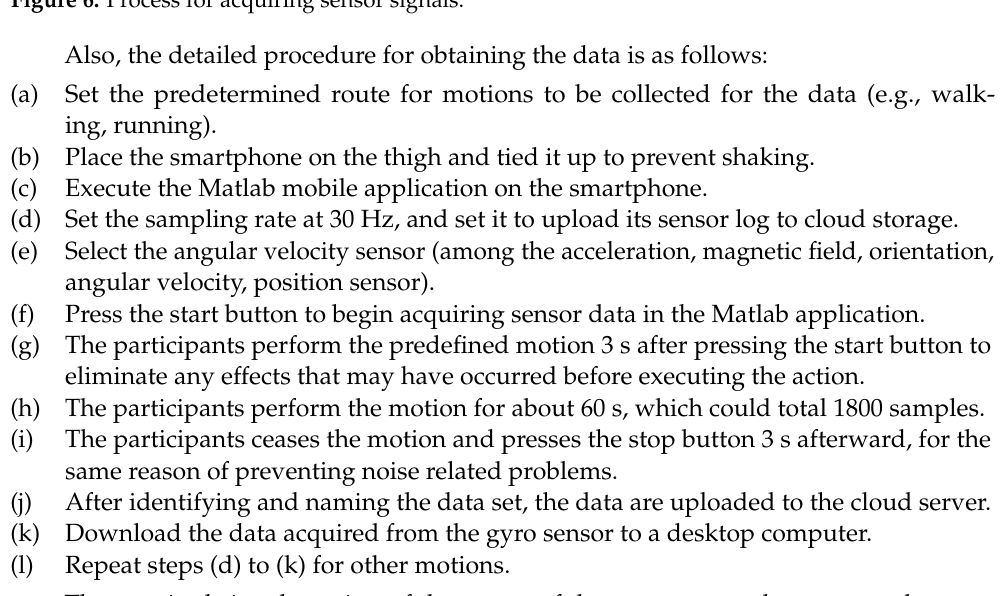
Figure 6. Process for acquiring sensor